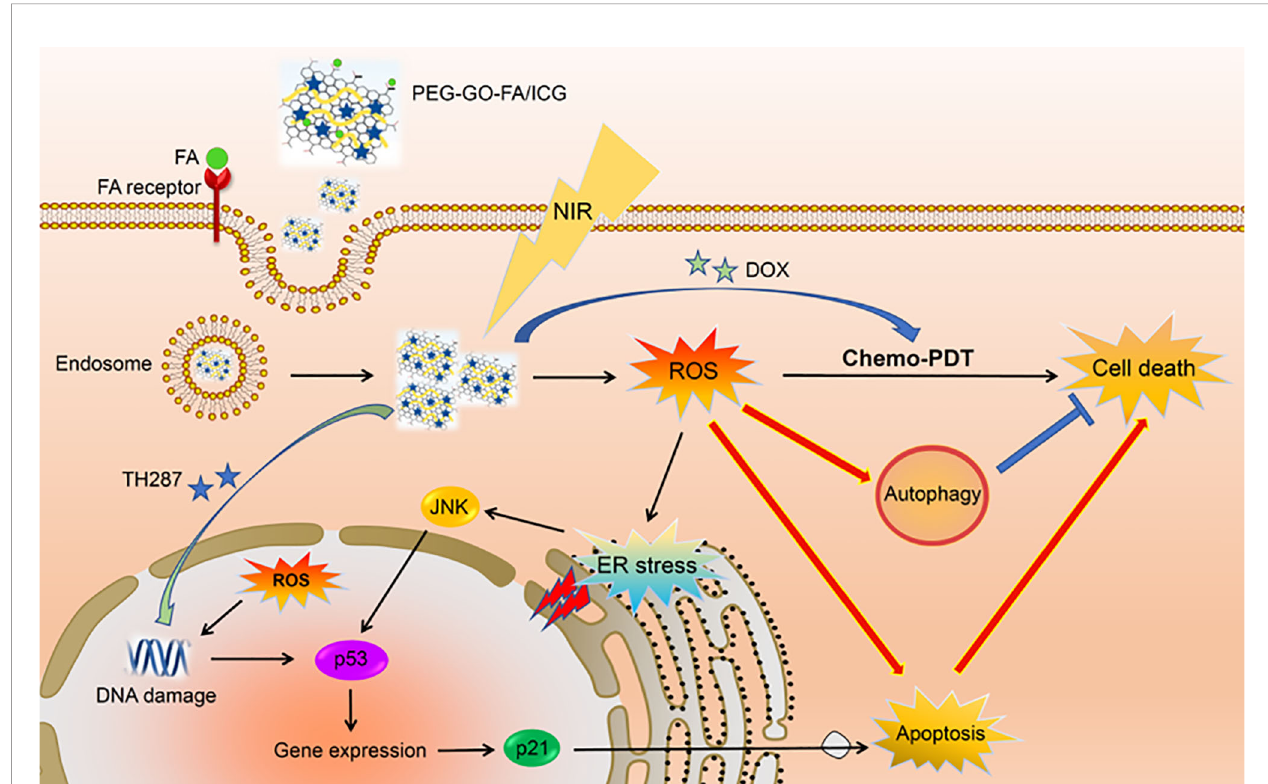
FIGURE 5 | PEG-GOFA/ICG nanoplatform is absorbed by OS cells through FA receptor-mediated endocytosis. Under NIR irradiation, PEG-GOFA/ICG nanoplatform has CHEMO-PDT synergistic effect to promote intracellular ROS production and release MTH1 inhibitor TH287 to enhance apoptosis induction of OS cells. Reproduced from (16) with permission from Acta